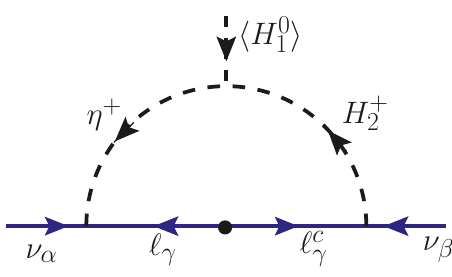
Figure 4 . Neutrino mass generation at one-loop level in the Zee model [14]. The dot ( SM fermion line indicates mass insertion due to the SM Higgs